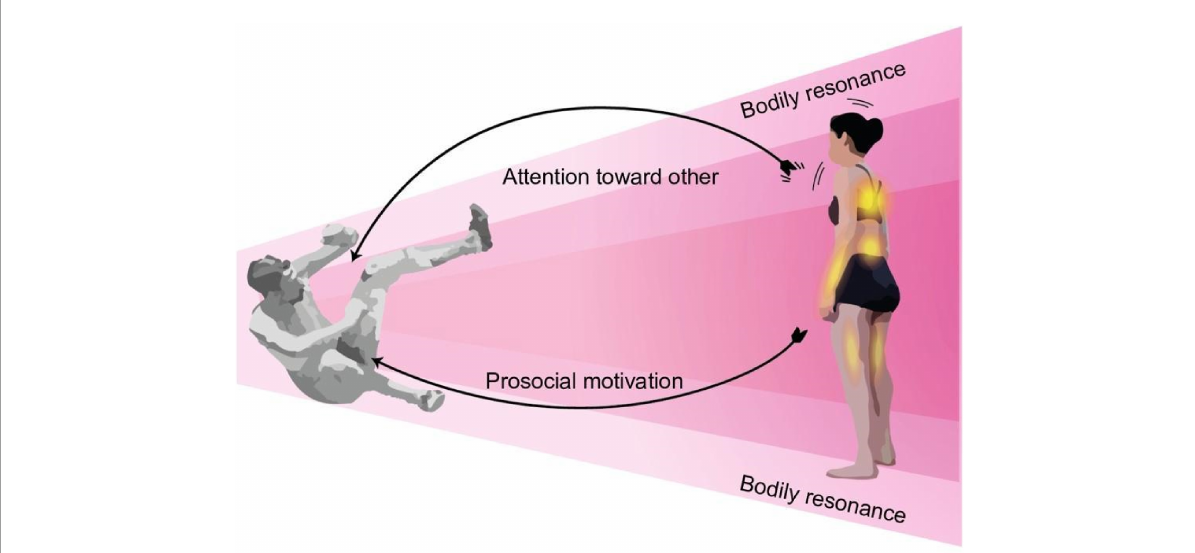
FIGURE4 Experiential structure of other-centered empathy for pain. The empathizer’s intentional object is the empathized experience; they see the sportsperson as sentient and having a painful experience. This empathic structure is characterized by bodily resonance, attentional focus centered on the sportsperson, and prosocial kinesthetic motivation to help